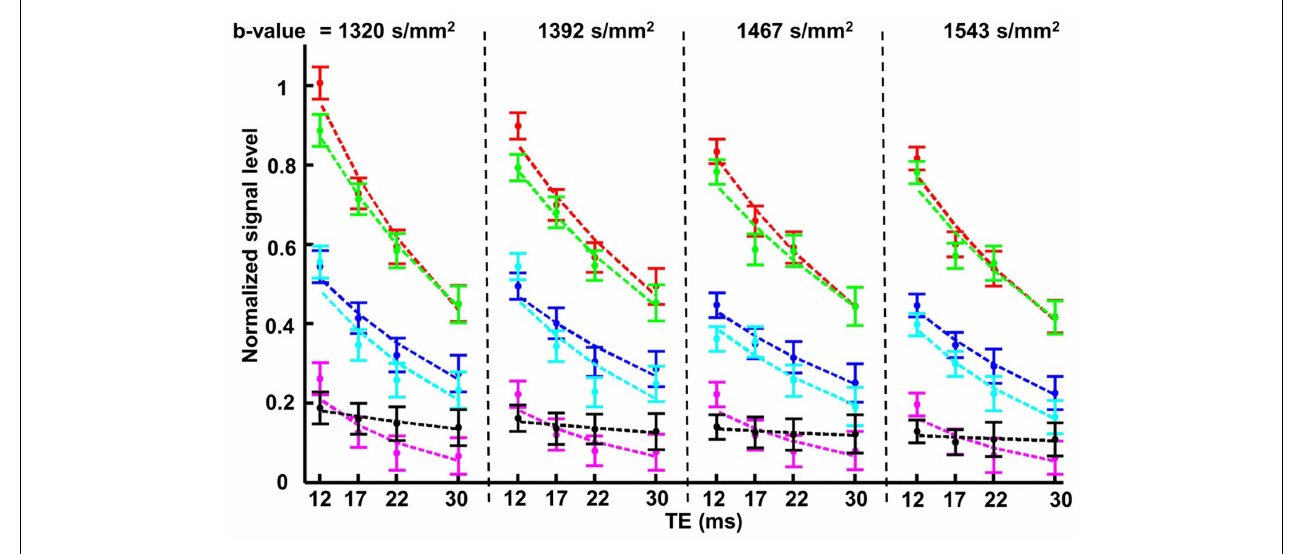
each compartment the four T E values tested with the respective b -value are indicated.The colors of the data plots correspond to the six color-coded regions of interest (ROIs) indicated in Figure 5A . Graphs of the mean and standard error of the signal measured in the respective color-coded ROIs are shown for all 16 combinations of b -value and T E . The dashed lines represent exponential curves fitted to estimate the T 2 values of various parts of the lens